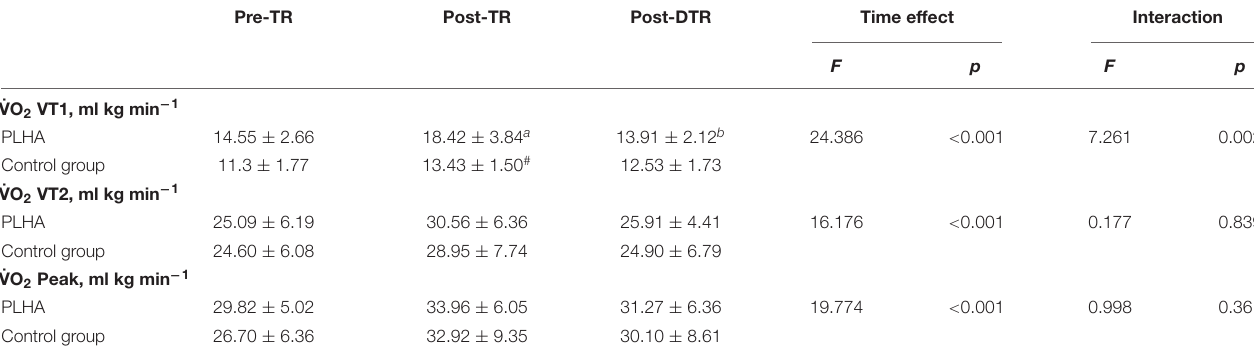
TABLE 5 | Descriptive and inferential results of oxygen uptake (Pre-TR, Pos-TR, and Post-DTR) for PLHA and CG. Pre-TR Post-TR Post-DTR Time